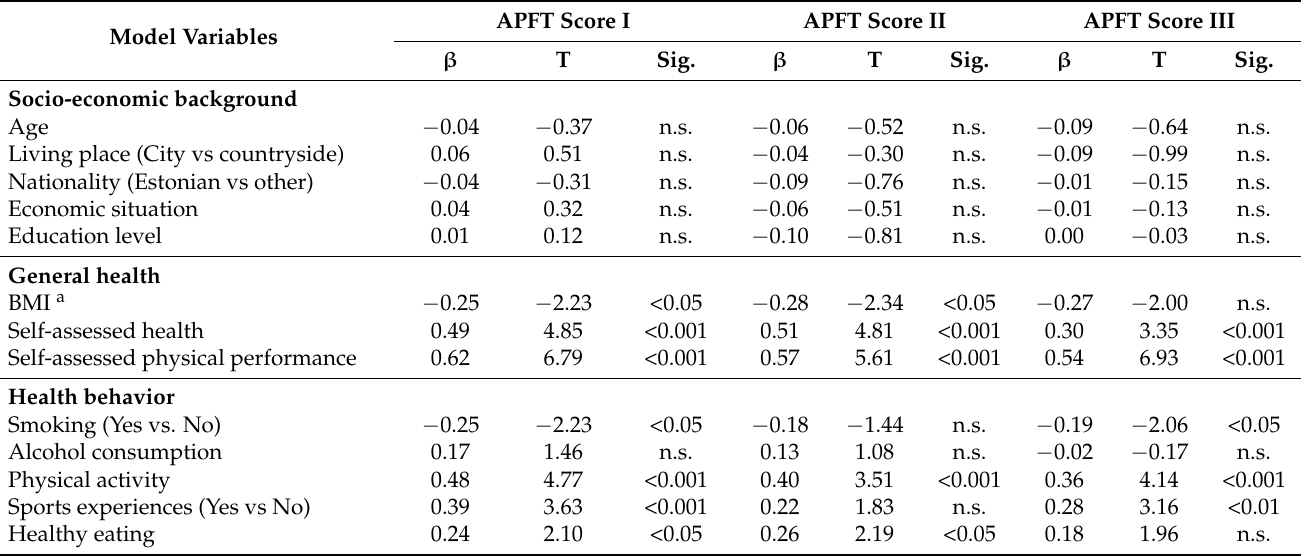
Table 3. The influence of socio-economic background, health characteristics and health behavior on conscripts’ (n = 235) APFT total score according to linear regression